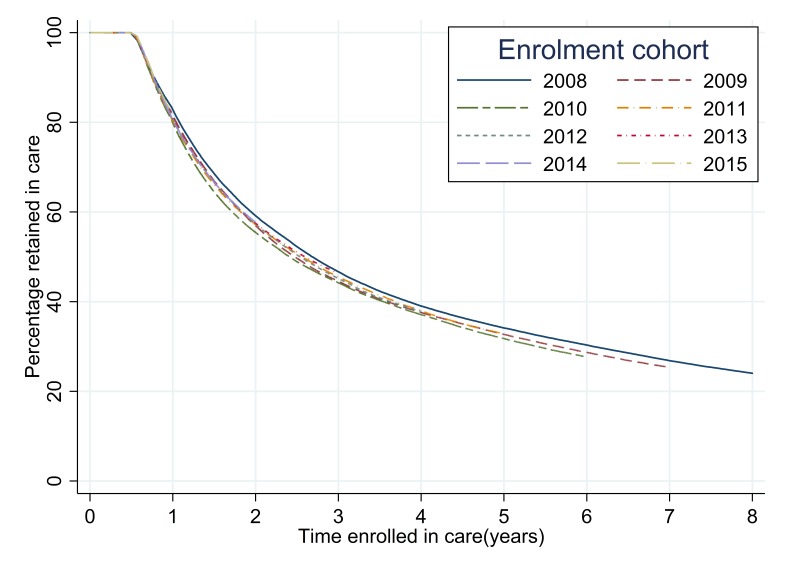
Time to event analysis of retention in care following enrolment for each successive annual enrolment cohort.